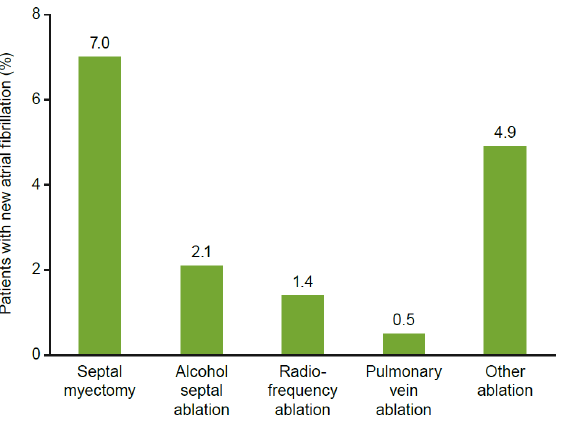
Figure 4. Drug therapy usage before and after septal myectomy or alcohol septal ablation.